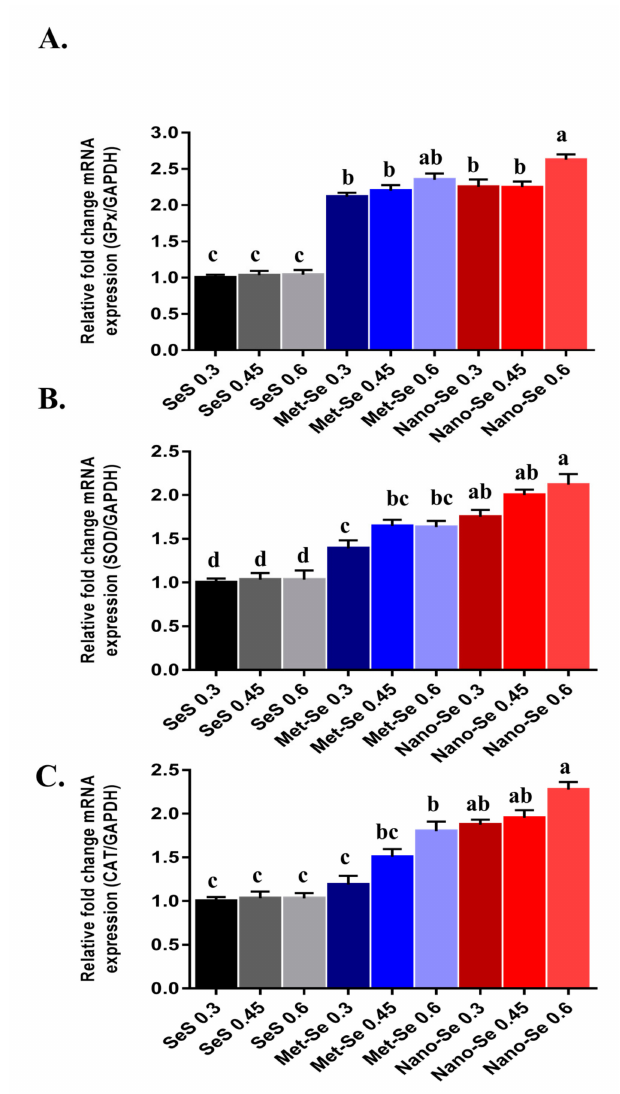
Figure 2. E ff ects of dietary Se source and level on the relative antioxidant enzymes expression ( A – C ). ( A ) Glutathione peroxidase (GPx); ( B ) super oxide dismutase (SOD); and ( C ) catalase